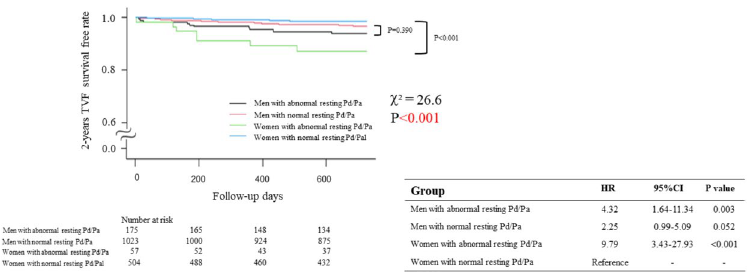
Figure 2. Kaplan–Meier time to event curves for target vessel failure during 2-year follow-up across the groups defined by normal/abnormal resting Pd/Pa and sex. The 2-year TVF survival free rate was stratified according to sex and resting Pd/Pa. In the risk comparison analyses, women with abnormal resting Pd/Pa showed the highest risk of 2-year TVF. Abbreviations are listed in Fig.